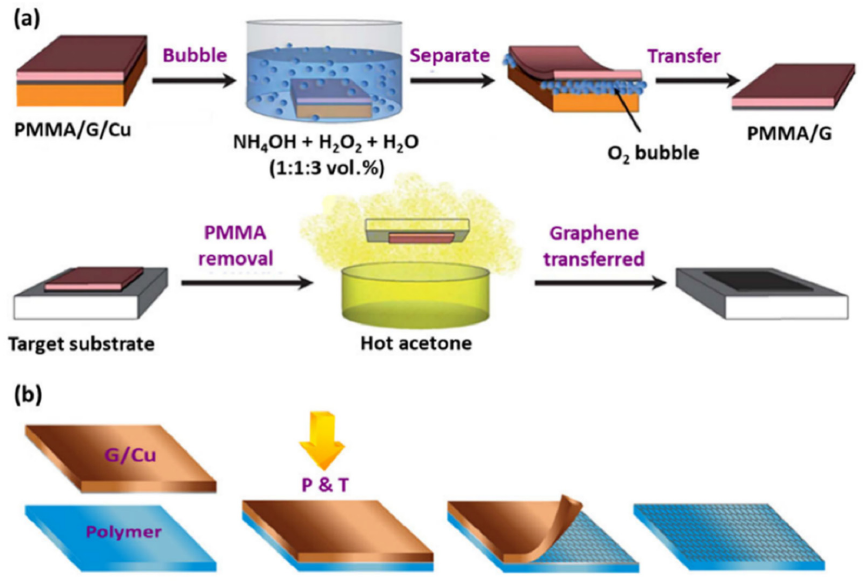
Figure 1. Two commonly-used transfer methods. ( a ) Wet transfer; ( b ) Dry transfer